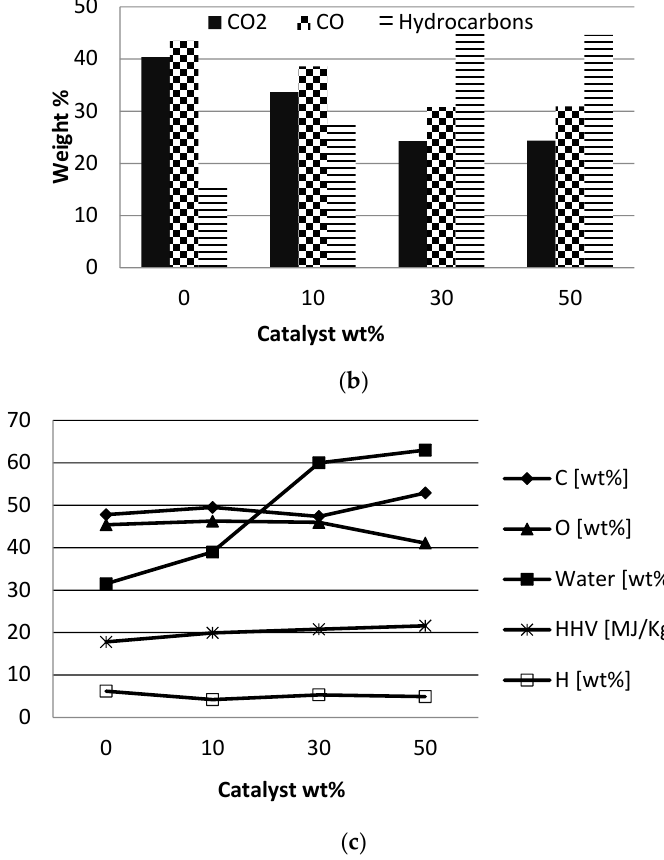
Figure 5. ( a ) Effect of the Na-Y/biomass ratio on pyrolysis products yields. ( b ) Effect of the Na-Y/biomass ratio on the gas composition. ( c ) Effect of the Na-Y/biomass ratio on the characteristics of the bio-oil.